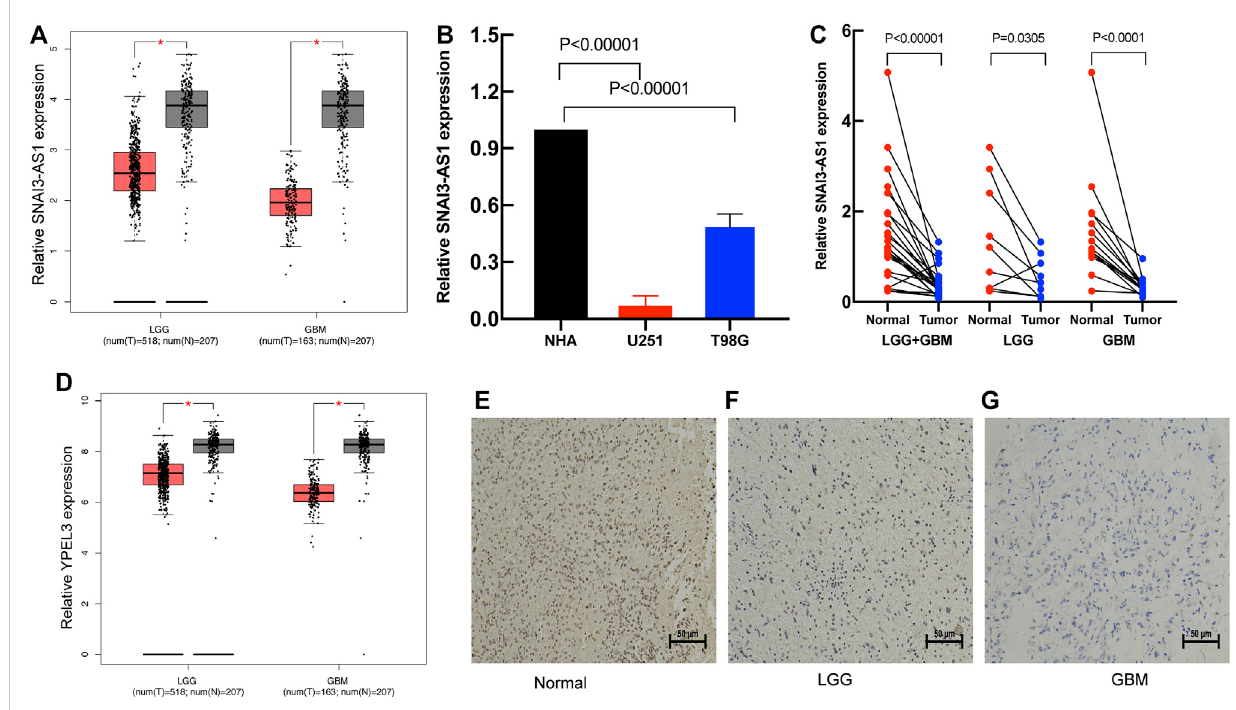
FIGURE 10 TheexpressionoftheSRlncRNAanditstargetgene. (A) TheexpressionofSNAI3-AS1isshowninGEPIA; (B) qRT – PCRwasusedtodetectSNAI3-AS1 expressionincelllines. (C) TheexpressionofSNAI3-AS1wasassessedusingqRT – PCRin24pairsofgliomaandmatchednormaladjacentbraintissue. (D) The expression of SNAI3-AS1 target gene (YPEL3). IHC staining for YPEL3 in (E) normal brain tissue, (F) LGG tissue, and (G) GBM